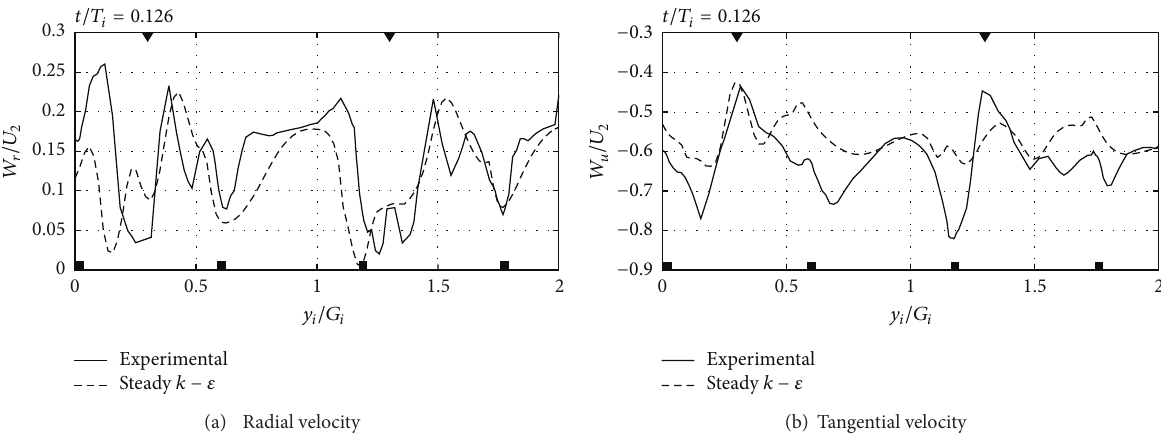
Figure 5: Radial and tangential velocities at the impeller outlet at midspan for the steady-state simulation using the 𝑘 − 𝜀 turbulence model.